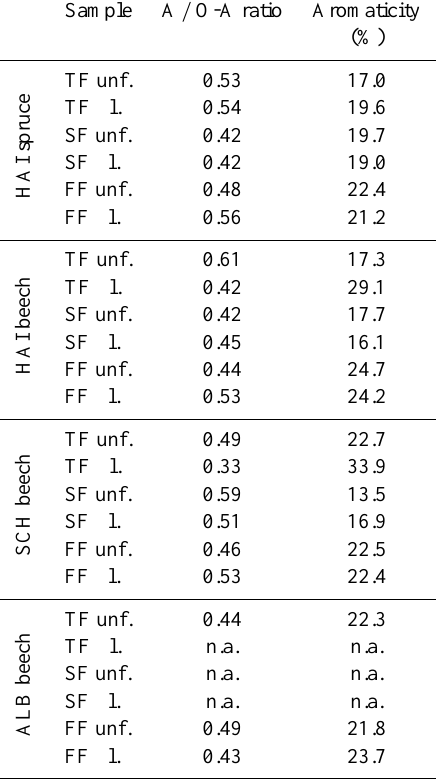
Table 4. Alkyl C / O-alkyl C (A / O-A) ratios and aromaticity (in %) calculated from chemical shift regions revealed by solid- state 13 C NMR spectroscopy of filtered (fil.) and unfiltered (unf.) samples of throughfall (TF), stemflow (SF) and forest floor (FF) leachates; n.a. – not analysed; ALB – Schwäbische Alb; HAI